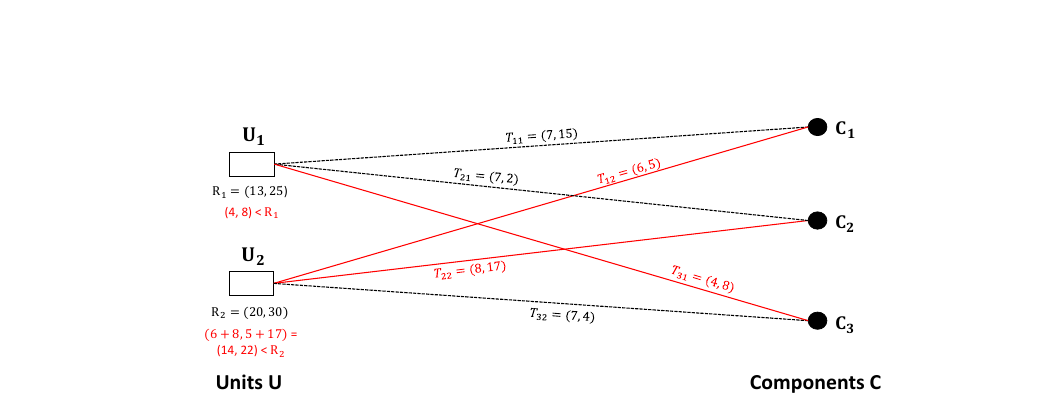
Figure 1. An example of a component allocation problem. Table 1. The set of all allocations for the component allocation problem example.